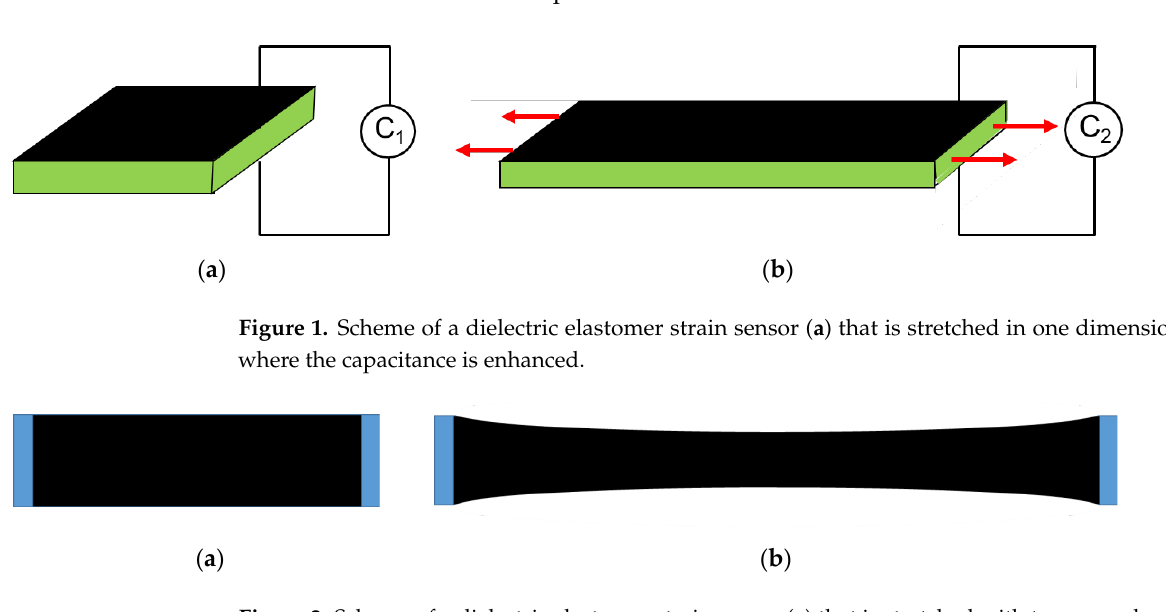
Figure 2. Scheme of a dielectric elastomer strain sensor ( a ) that is stretched with transversal contrac- tion ( b